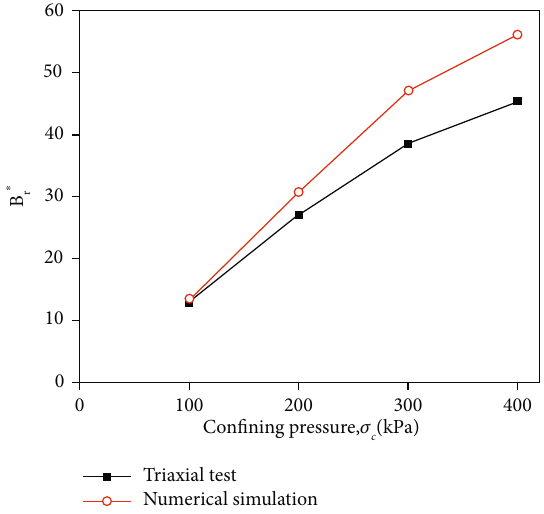
Figure 5: Comparison of particle breakage factor in triaxial test. Table 4: Particle crushing number under di ff erent working